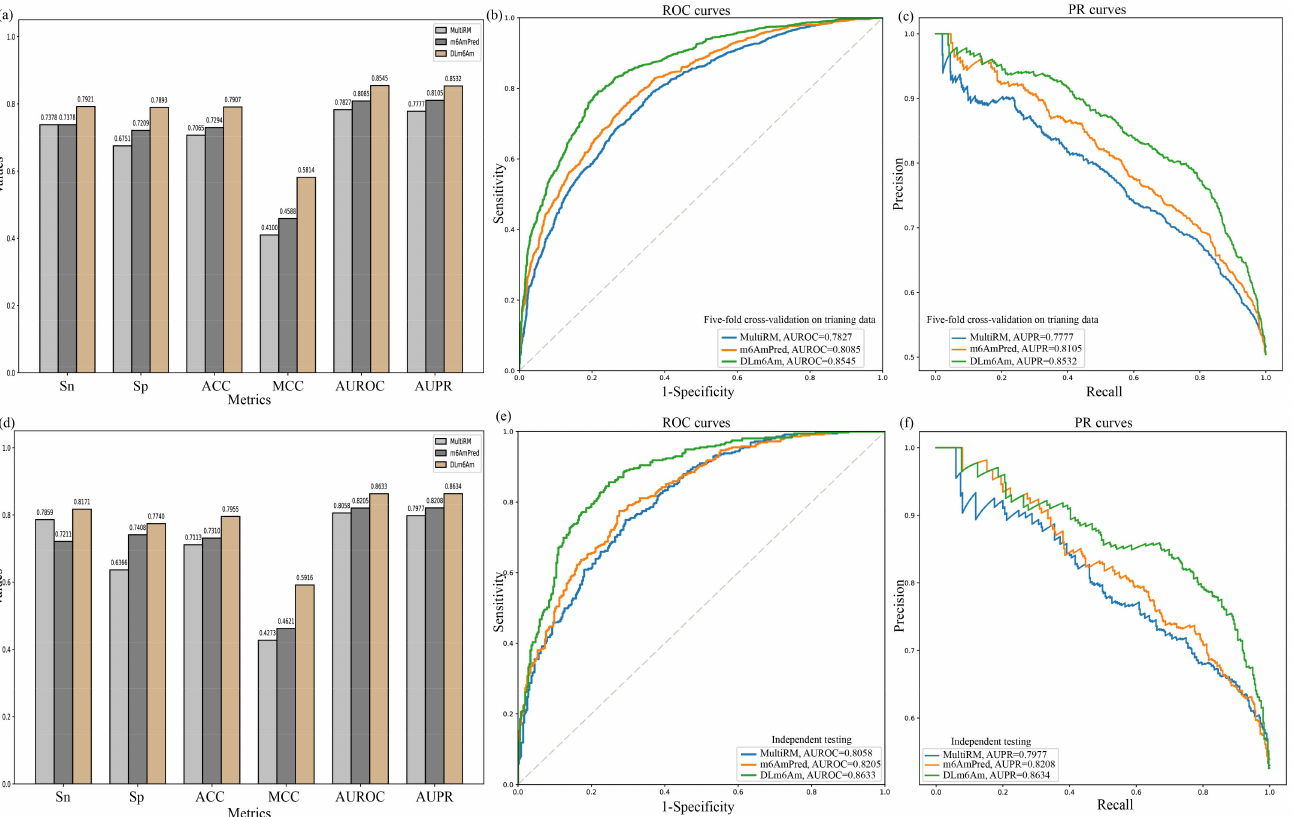
Figure 5. Performance comparison with existing methods. ( a – c ) Performance comparison between MultiRM, m6AmPred, and our method DLm6Am using five-fold cross-validation on training data. ( d – f ) Performance comparison between MultiRM, m6AmPred, and our method DLm6Am using independent testing